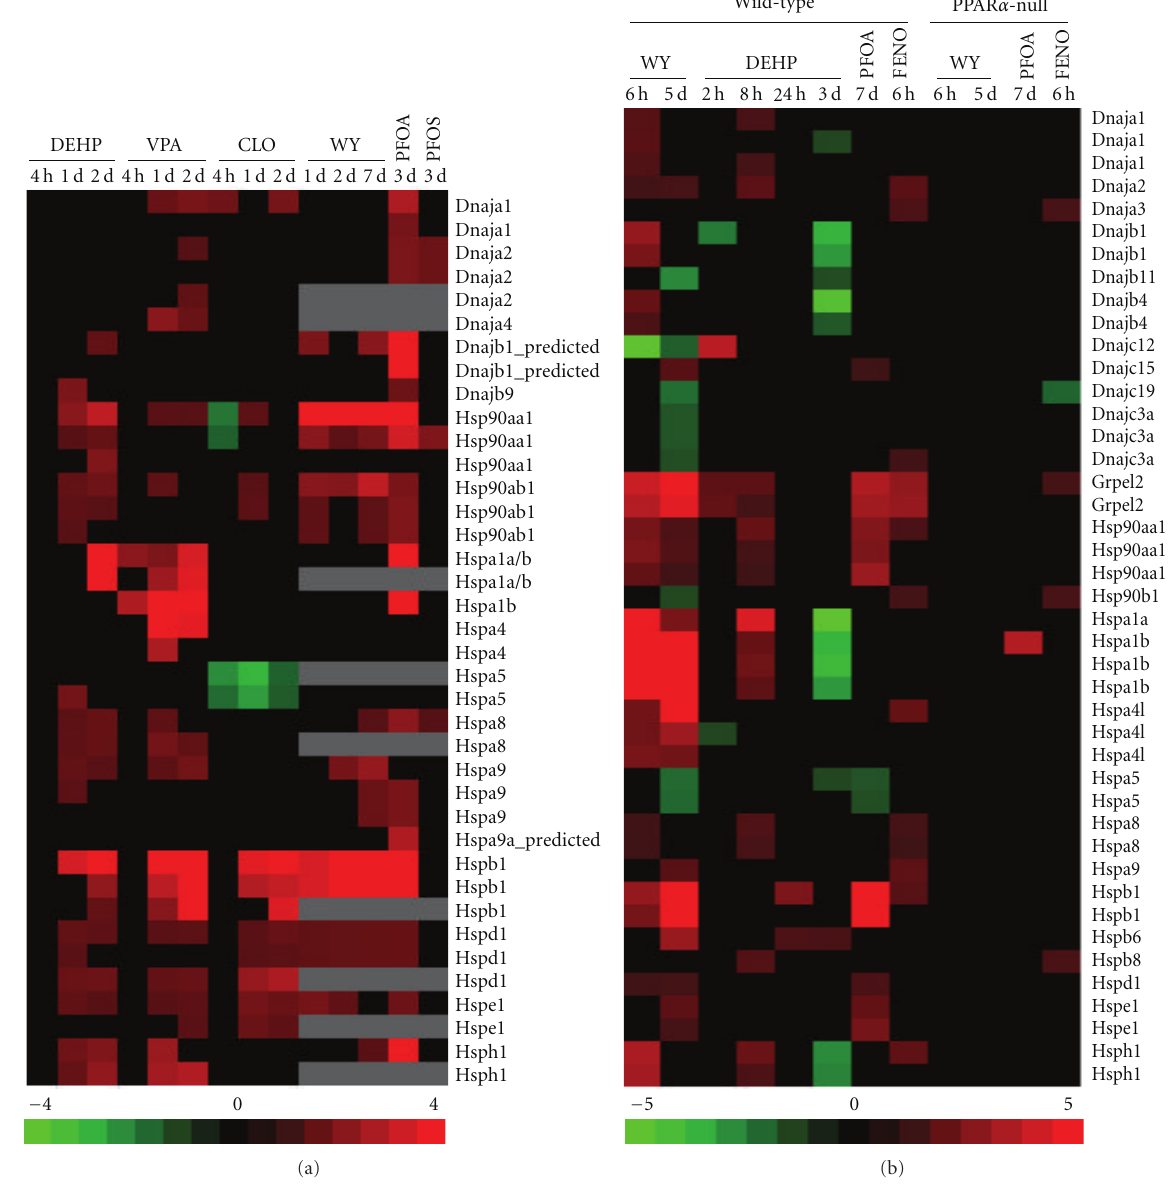
Figure 4: Expression of the protein chaperone genes in the rat and mouse liver after PPC treatment. Protein chaperone gene expression was examined in the (a) rat liver or (b) mouse liver after PPC exposure using the studies described in Figures 1 and 2. Genes which exhibited altered expression in at least one of the treatments are shown. Genes are presented in alphabetical order. Many genes were represented by more than one probe